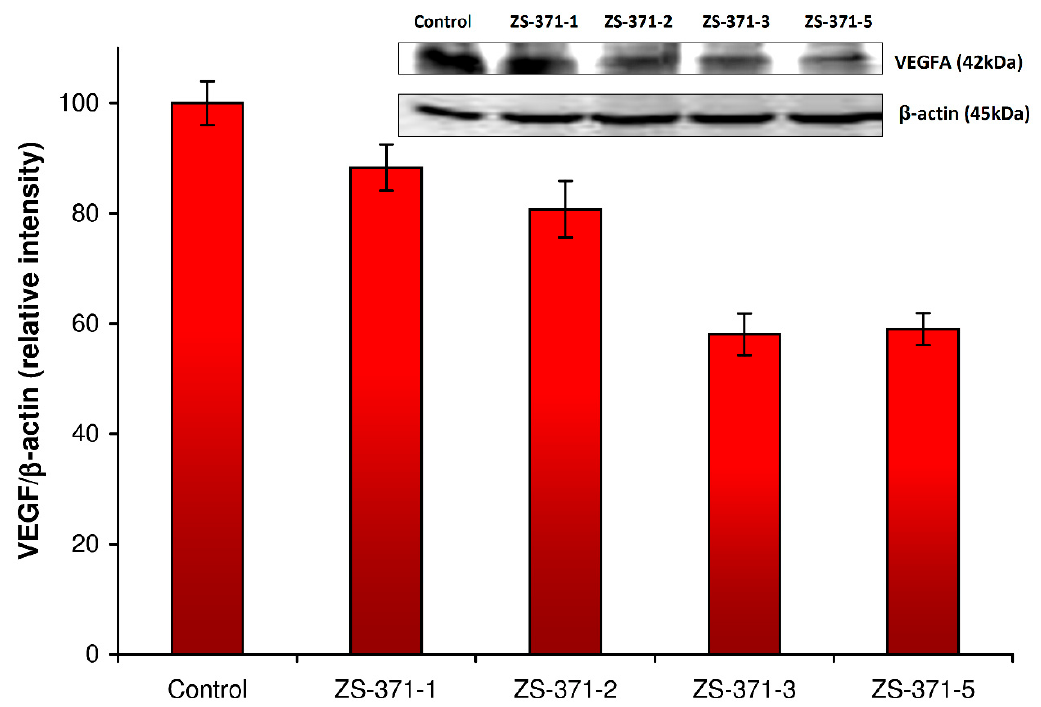
Figure 9. Western blot study of VEGF silencing in A549 cancer cells after 24 h. Data represent mean ± SD (* p < 0.05, n = 4). Insertion demonstrates a typical membrane image after visualization of the